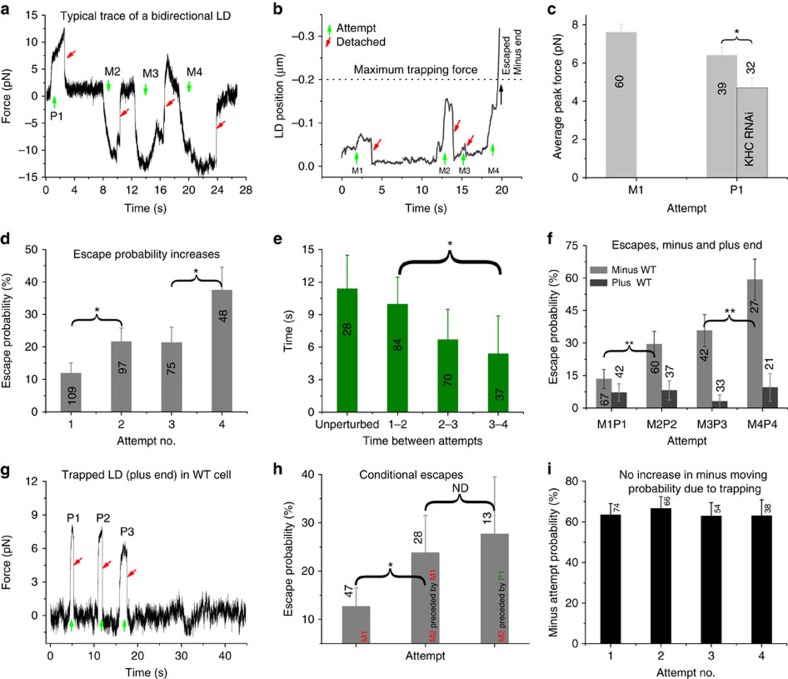
Force adaptation occurs for lipid droplets (LDs) in vivo in the minus end direction.(a) Typical trace of LD escaping the optical trap. In the figures, ‘M#' and ‘P#' denote direction and escape attempt # of the LD in laser trap, that is, the first escape attempts towards the minus and plus end of the microtubule are denoted by ‘M1' and ‘P1', respectively. Unless mentioned otherwise, the numbers in/above the bars in the figures hereafter are the N values for the measurements. (b) High resolution bi-directional force trace of a LD showing increased minus-end force persistence and higher force with time. (c) Average peak plus end forces decrease due to KHC siRNA treatment (data shown is from 2 different sets of cultures from ∼25 cells and reduced forces were observed in four trials). (d) Probability of LDs escaping from the laser trap increases with attempt number. (e) Average time between periods of linear motion (Unperturbed) or attempts (when trapped) of LDs in WT cells. (f) Percentage of LDs escaping from the trap in the minus- and plus-end directions as a function of attempt number. (g) Trace showing lack of adaptation in the plus end moving LD in the trap. (h) Minus-end adaptation occurs even when a previous (failed) attempt was in the plus-end direction. (i) No change in the probability of a given attempt occurring in the minus end direction as a function of attempt #. (In d–h, trajectories of 109 LDs were analysed from cells cultured on four different days. At least five cells were analysed in each dish lasting for about an hour. See methods. Overall, force persistence adaptation of LDs was observed in more than 20 different sets of WT cultures.) *P<0.05, **P<0.01, t-test Error bars=s.e.m.